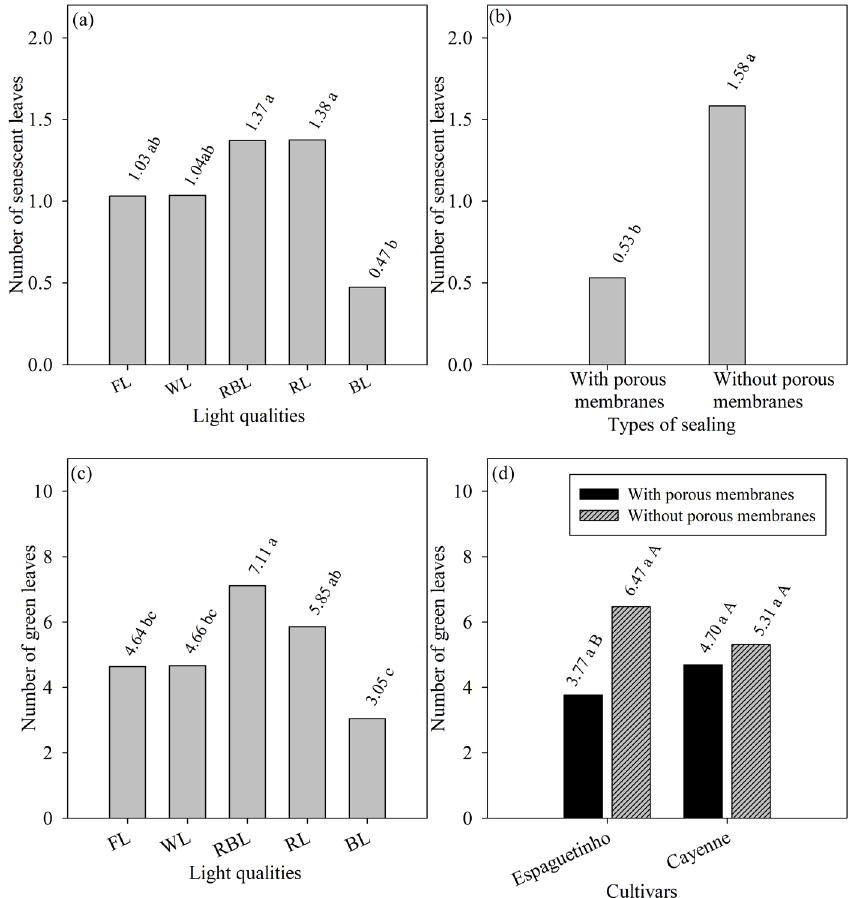
Figure 4. Growth variables of Capsicum frutescens cv. cultivated under different sealing. Number of senescent